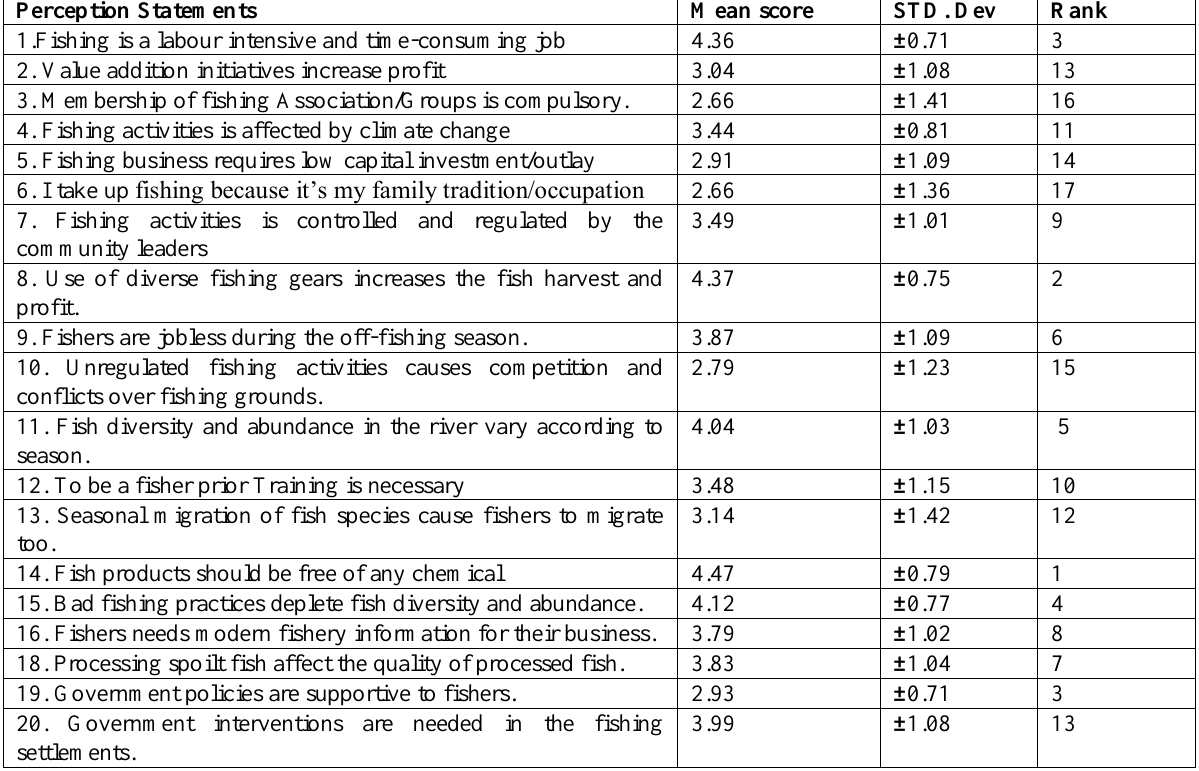
Table 3. Perception on artisanal fishing enterprise